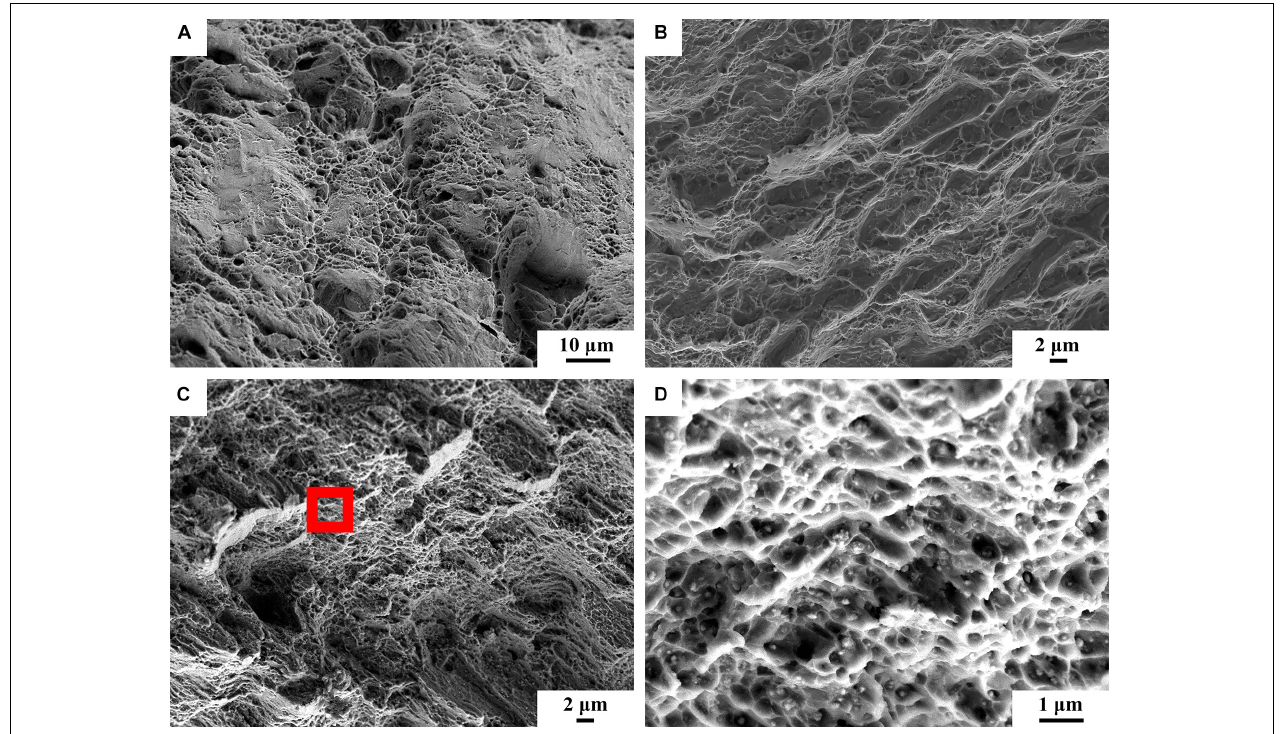
FIGURE 10 | The fracture surfaces of tensile samples: (A) BM, (B) FSP, (C) FSP-ZrO 2 , (D) the enlarged view of red rectangle of (c)